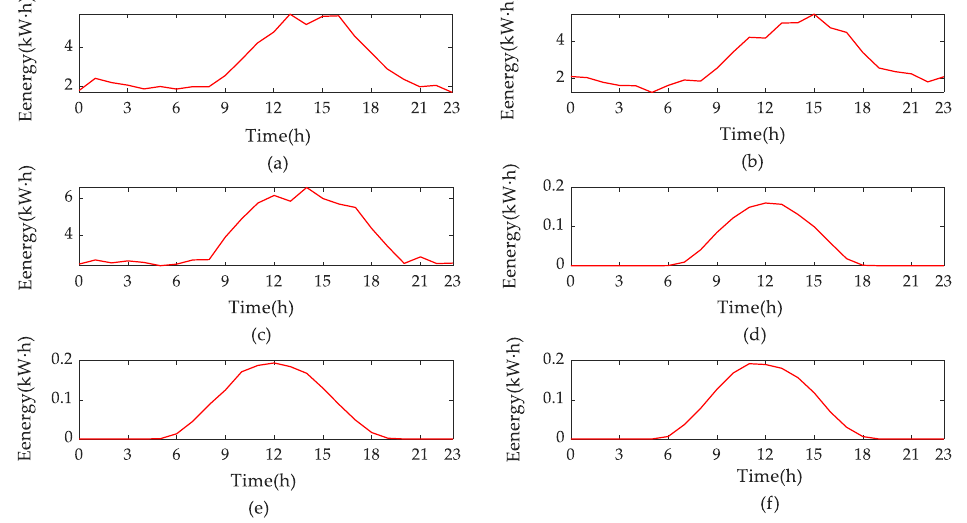
Figure 5. Different output energy of the separate production (SP) and WT in a typical day. ( a ) The power generated by a WT on a typical day in heating season; ( b ) The power generated by a WT on a typical day in cooling season; ( c ) The power generated by a WT on a typical day in transition season; ( d ) The power generated by a PV on a typical day in cooling season; ( e ) The power generated by a PV on a typical day in heating season; ( f ) The power generated by a PV on a typical day in transition